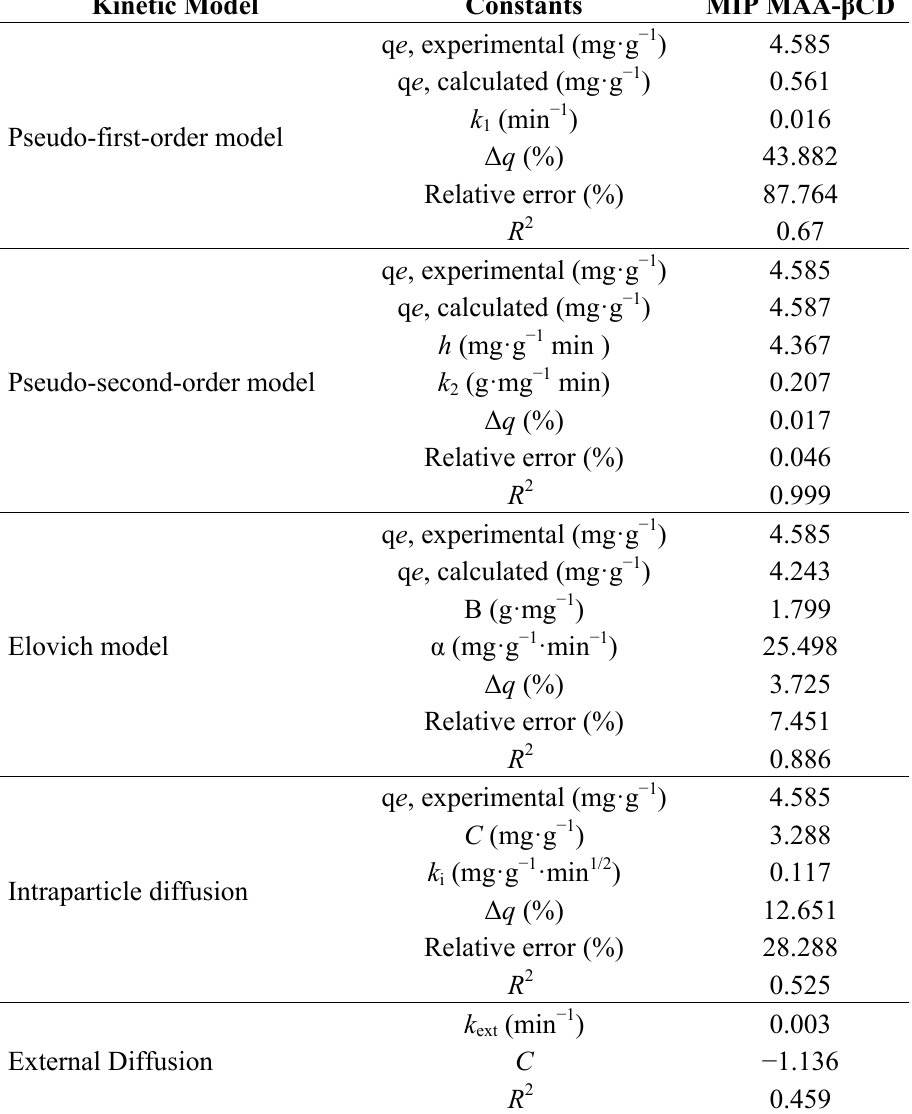
Table 2. Kinetic parameters for 2,4-DCP adsorption onto MIP